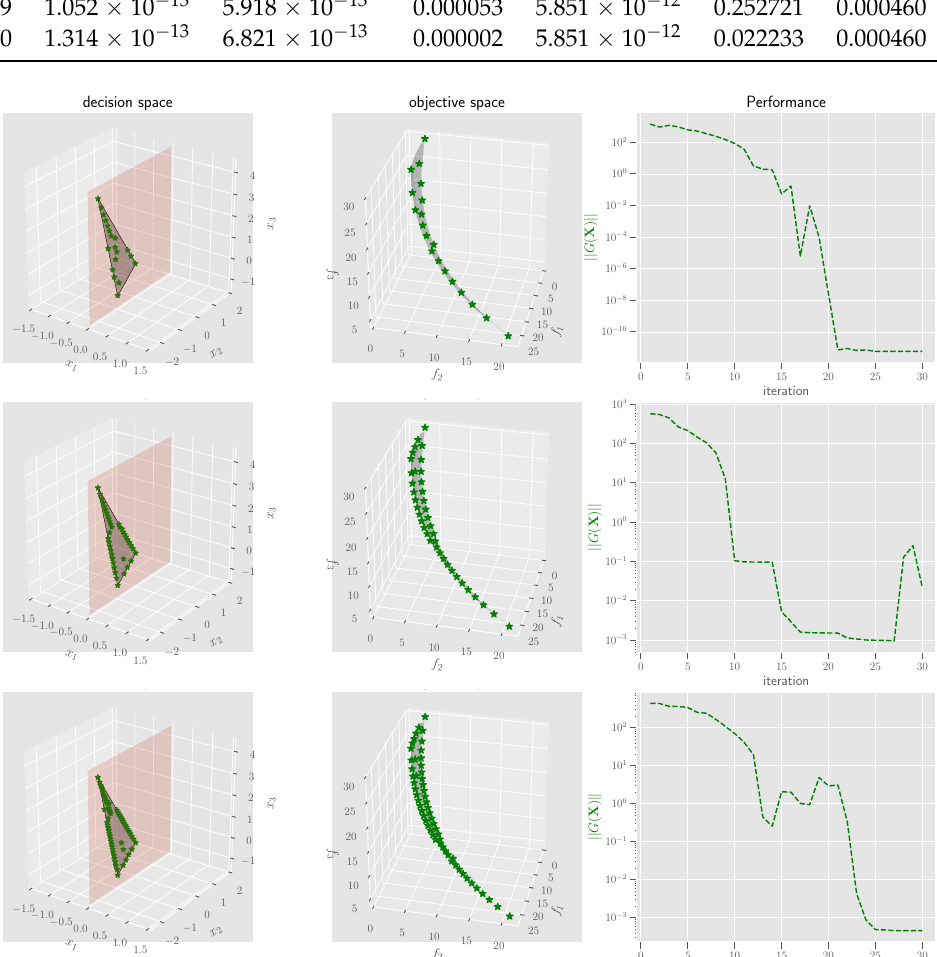
Figure 4. On problem P3 with a spherical constraint, we depict for three sizes of the initial approx- imation set ( µ 20,40,60 ; from top to bottom ), the final approximation set ( left column ; green ∈ { } stars), the corresponding objective points ( middle column ; green stars), and the evolution of the HV G ( X ) value and ( right column ). The initial decision points are sampled uniformly at random in (cid:107) (cid:107) [ the feasible space of [ 0,4 ] 4,4 ] 2 × −